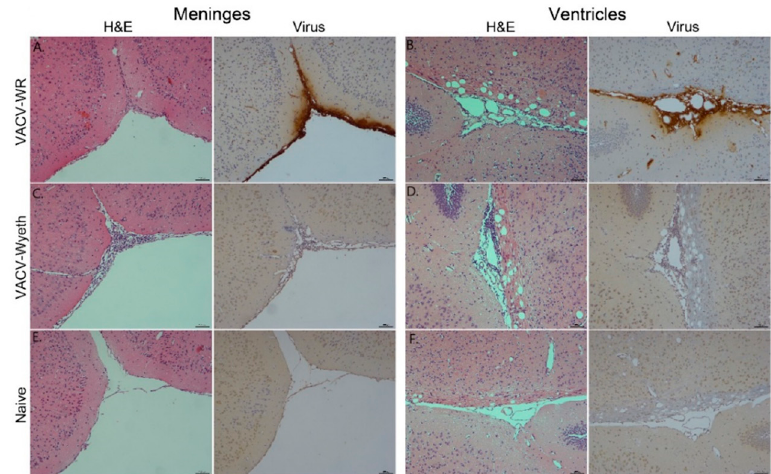
Figure 2. Detection of VACV-WR but not VACV-Wyeth antigens in the meninges and the ventricular system. Brain sections, 5 d.p.i with VACV-WR (10 2 pfu) or VACV-Wyeth (10 6 pfu) stained with Hematoxylin and Eosin (H&E) or with antibodies to VACV (positive stain in brown). ( A , B ) VACV-WR. ( C , D ) VACV-Wyeth. ( E , F ) Carrier-injected control. Meninges (A,C,E—serial sections) and ventricles (B,D,F—serial sections) areas are shown. Table 1. Histology evaluation of viral presence and immune response at the symptomatic stage following infection. Virus Meninges Cortex